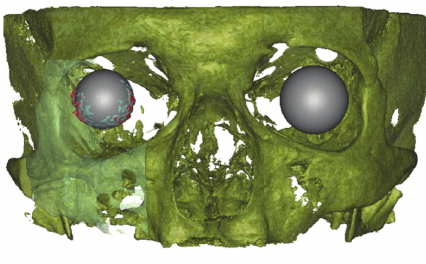
Figure 8: Volume rendering of the scanned volume with the orbital implant and the contralateral corpus vitreum (patient ID